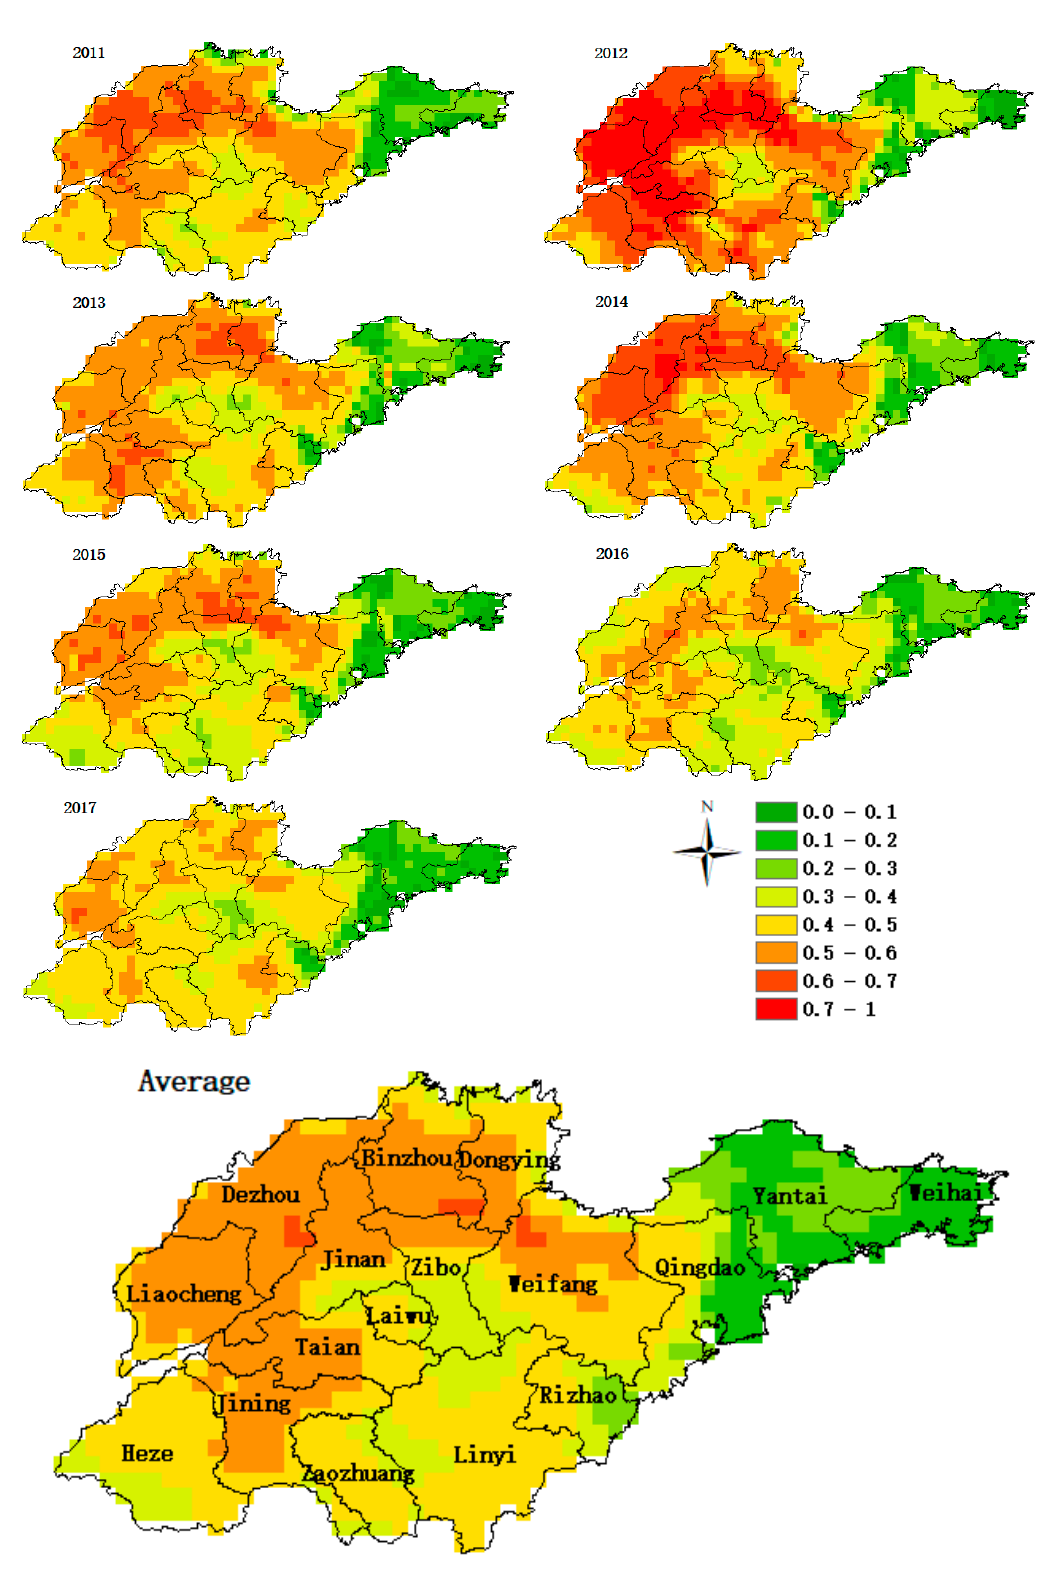
Figure 4. Aerosol Optical Depth (AOD) distribution map of Shandong Province.